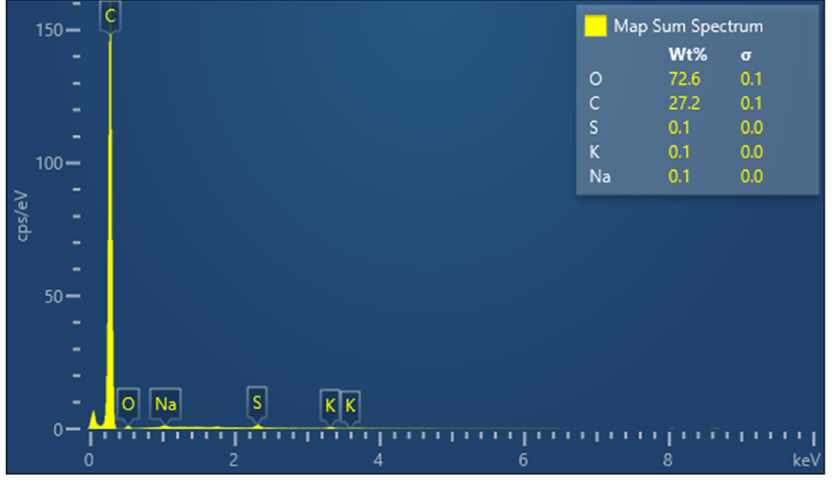
Figure 4. Percentage distribution of the component elements of the diluted latex.